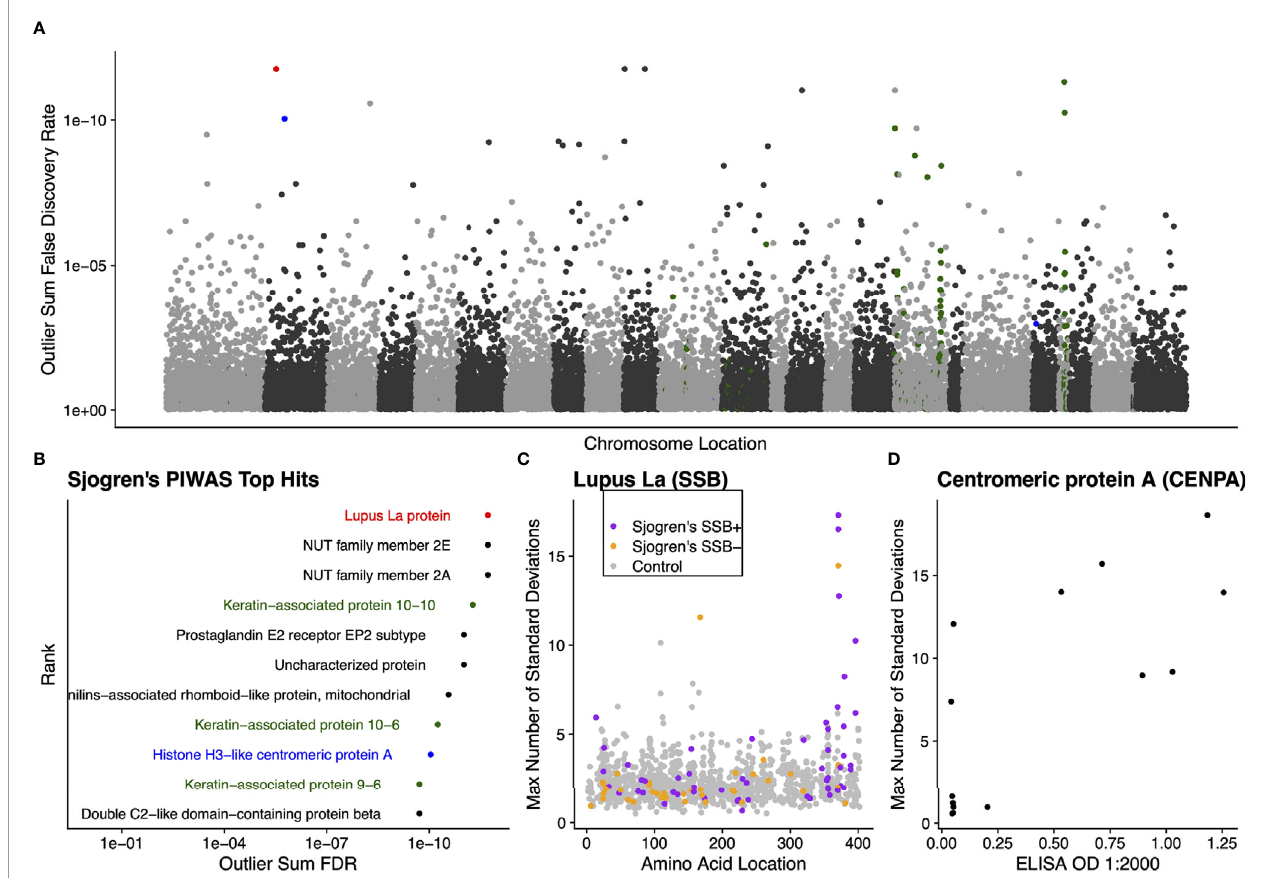
FIGURE 5 | Literature reported and putative autoantigens are detected in Sjogren ’ s syndrome samples by PIWAS. (A) PIWAS results from a comparison of Sjogren ’ s syndrome samples to controls against the human proteome were prioritized using outlier sum FDR as a measure of signi fi cance (y-axis, see Methods ). For visualization, proteins were laid out according to chromosome location. (B) Among the top set of 11 ranked proteins, 5 are established autoantigens (Lupus La/SSB in red, centromeric proteins in blue, keratin proteins in green). (C) Strength (y) and location (x) of PIWAS scores for the Lupus La protein/SSB for Sjogren ’ s samples that are predicate SSB+ (n=54, purple) or predicate SSB- (n=37, orange) vs. control (n=1,157, grey). (D) Comparison of PIWAS score (y) and CENPA ELISA OD (x) for Sjogren ’ s samples that we tested by ELISA